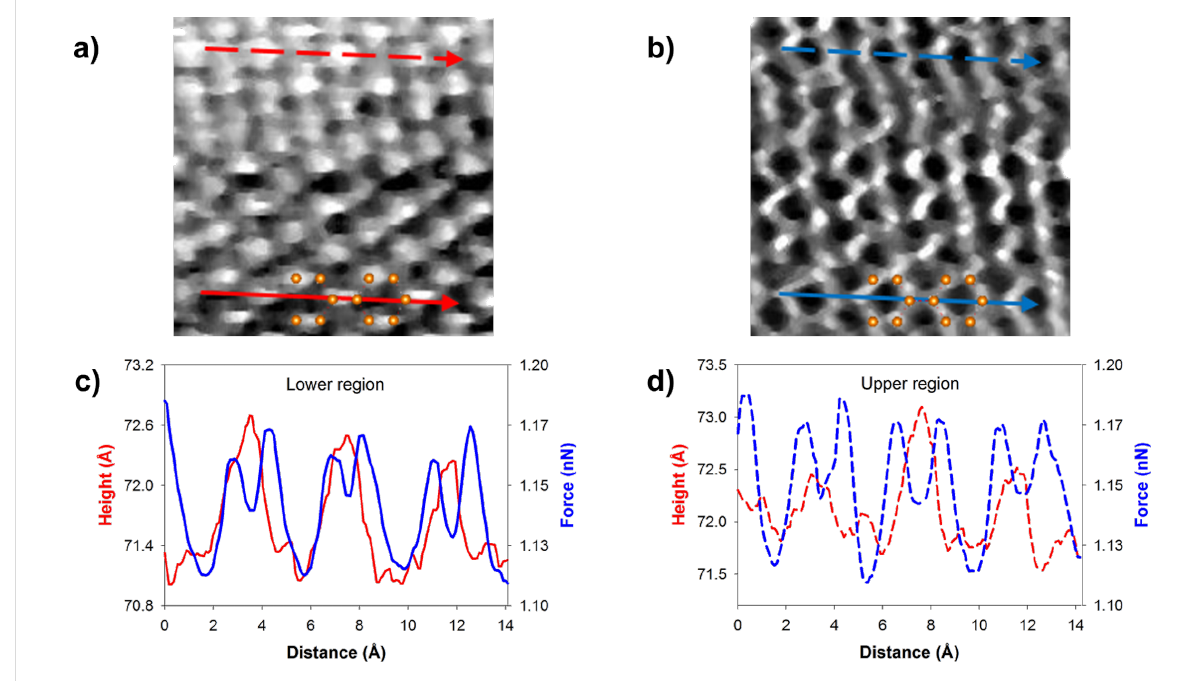
Figure 3: Simultaneous STM/AFM images of a graphene surface. (a) STM topography in constant-current mode (forward scan); (b) force in constant- height mode (backward scan). A pair of hexagonal unit cells is superimposed on the images. The profiles along the indicated lines are given in panels (c) and (d). Images obtained with a W cantilever of stiffness k = 53 N/m and a resonance frequency f 0 =31.5 kHz; drive frequency f = 15 kHz. The image size is 18 × 18 Å 2 ; V sample = 0.5 V, I t = 0.6 nA, free amplitude A 0 = 0.3 Å rms